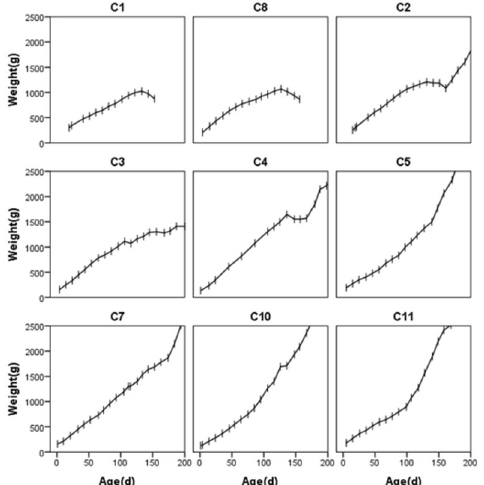
Fig 1. Cumulative body mass growth curves for nine Sunda pangolin ( Manis javanica ) cubs from birth to 200 days of age.